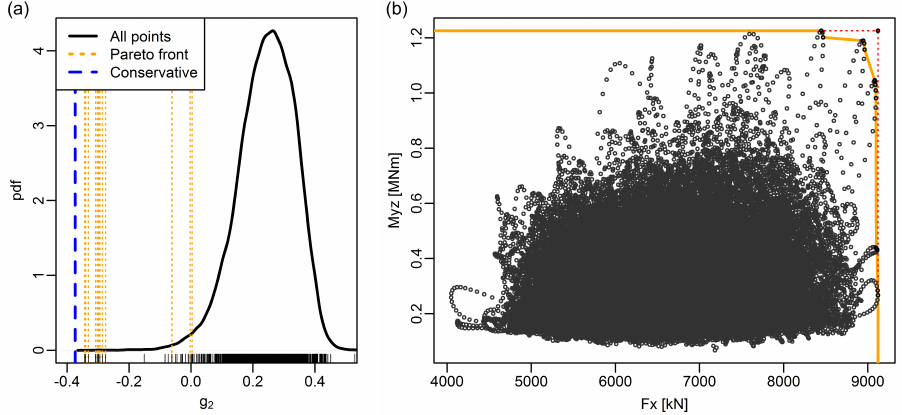
Figure 7. Results for the bottom joint in the OC4 jacket support structure at rated wind speed (DLC 1.3). ( a ) The distribution of the limit state function evaluated at all points in time. The broken blue line indicates the value for the conservative combination of univariate maxima. The dotted orange lines indicate the values for the Pareto-optimal points. The solid line is an estimate of the underlying distribution, i.e. , the theoretical case for an infinite number of samples. The actual samples from the time series are indicated with short black line segments at the bottom. ( b ) Scatter diagram showing axial force and bending moment. The Pareto-optimal front is indicated in orange. The single red point in the top right corner is the point obtained by the conservative approach. Note that, in contrast to Figure 1, the complete time series was